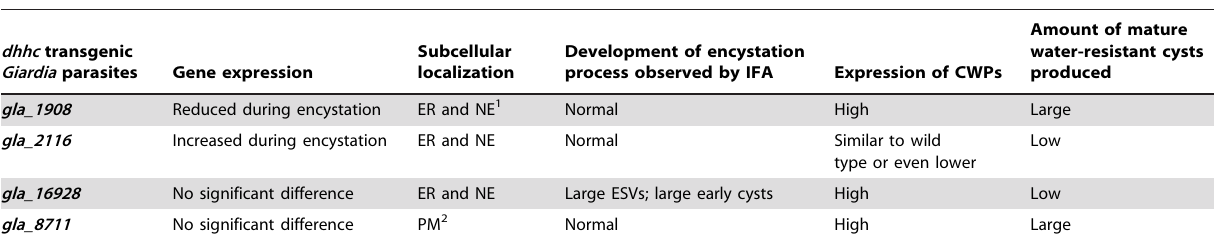
Table 2. Main features of the Giardia DHHC proteins analyzed in this